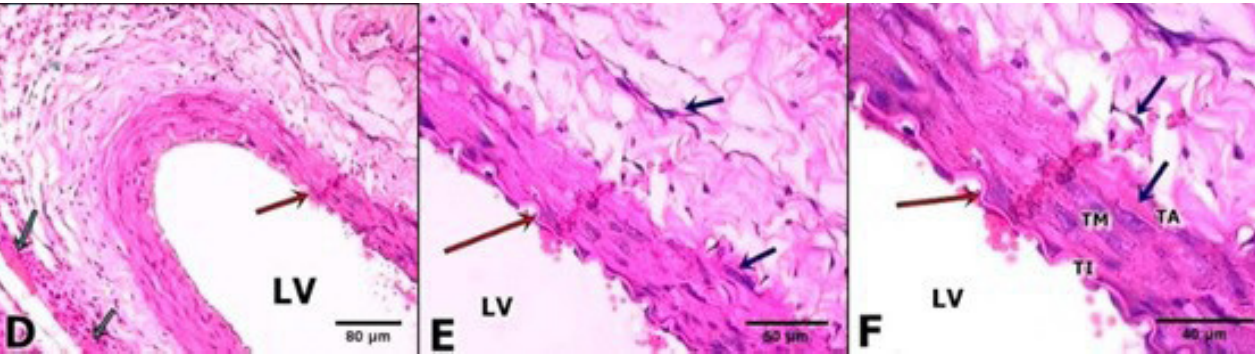
Fig. 2 - D, E and F belonging to the Chitosan Group (ChG) In D (20x magnification), a discrete hematic infiltrate is observed in the vascular wall, as well as a quantity of leukocytes and fibroblasts, in a more preserved tissue area. Details in E (40x) and F (60x) with clear division of the tunic intima (TI), media (TM) and adventitia (TA) , closer to the great support of collagen fibres and elastic fibres. Note green arrows in D indicate the presence of degraded remnants of